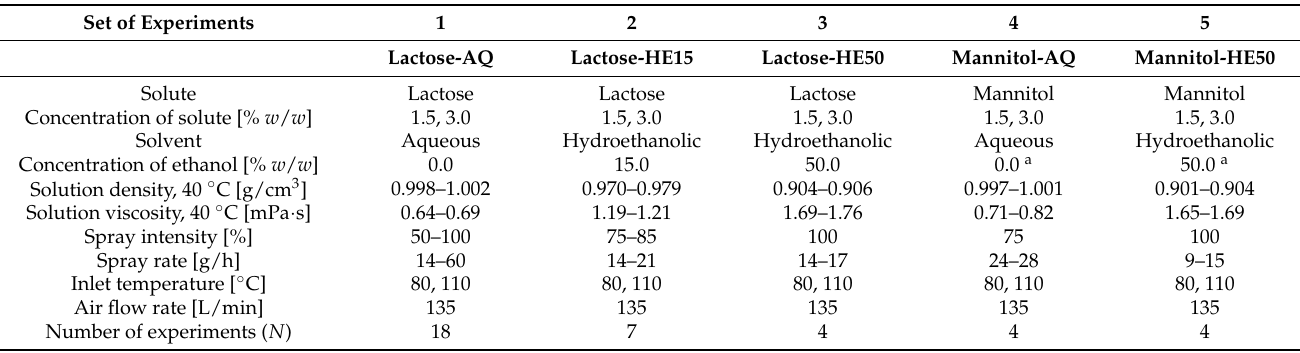
Table 2. Design of nano spray drying